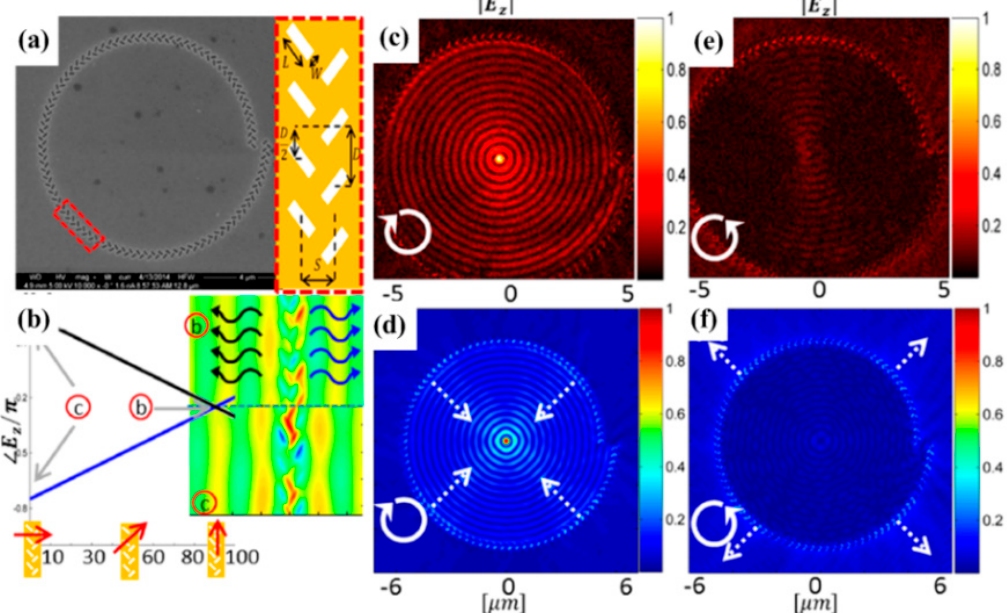
Figure 7. ( a ) SEM and schematic illustration of the fishbone structures. ( b ) Linear phase dependence of surface plasmon polaritons as a function of the polarization orientation. ( c ) Experimental SNOM and ( d ) calculated results for right circularly polarized incidence. ( e ) Experimental SNOM and ( f ) calculated results for left circularly polarized incidence. Reproduced with permission from [128].